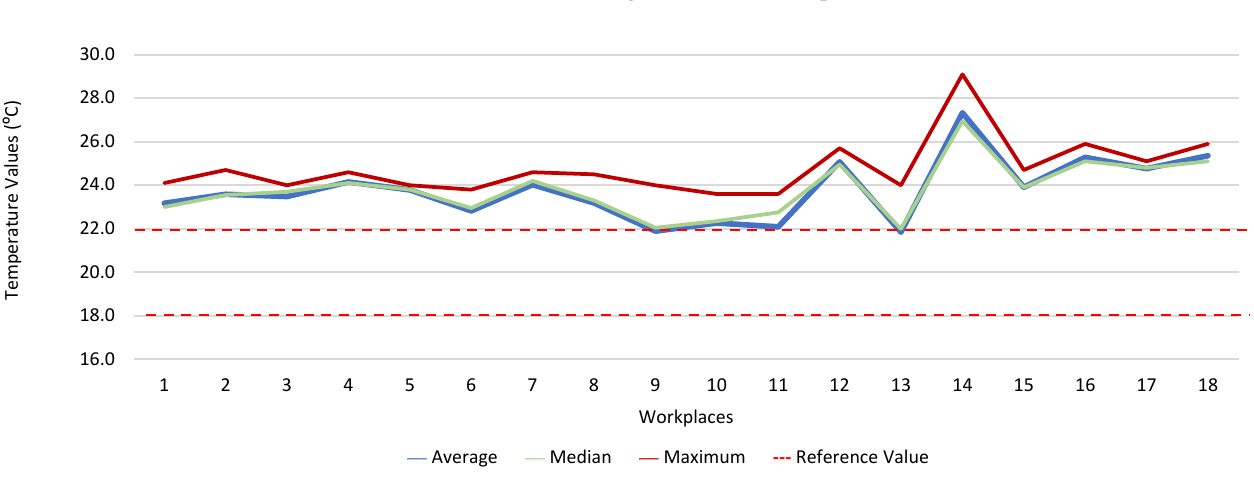
Figure 16. PM 10 concentration ( μ g·m − 3 ) inside workplaces.